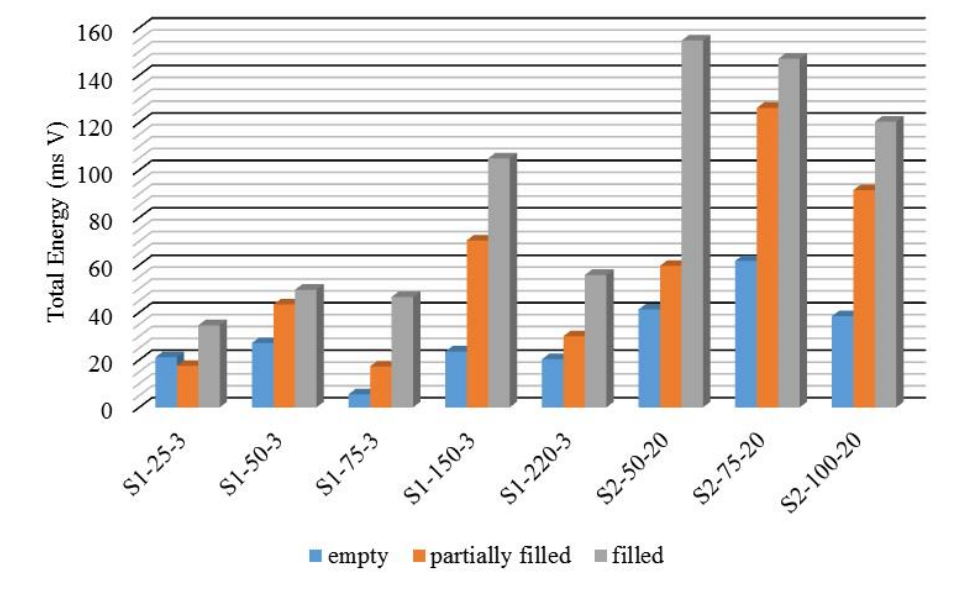
Figure 9. Total energy